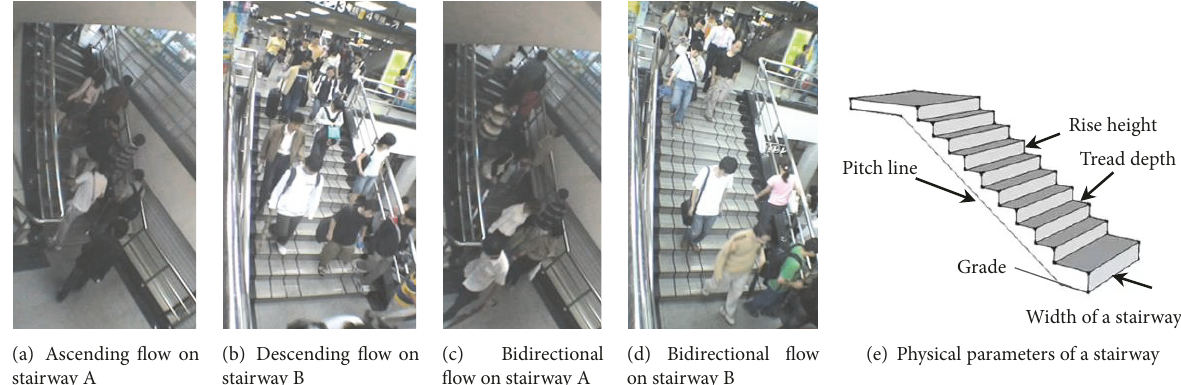
Figure 1: Two stairways observed with different flow